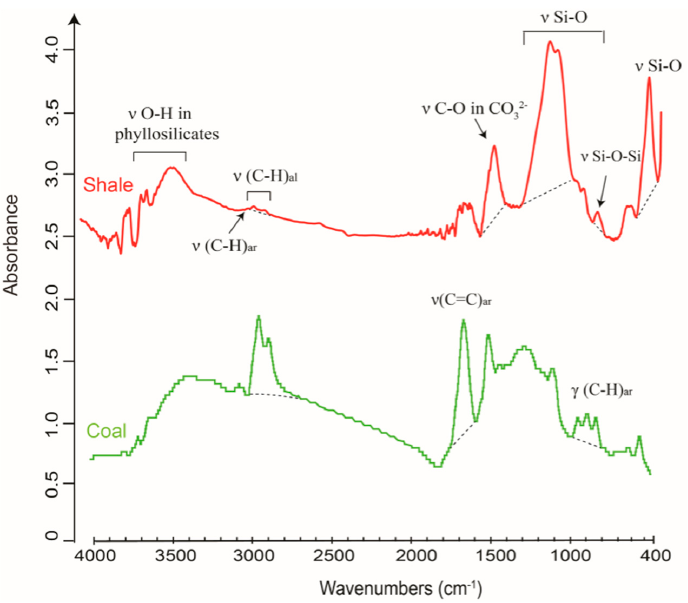
Figure 6. Comparison between the spectra of shale (red) and coal (green). Dashed lines are the linear baselines applied to the FTIR spectra. Note that the IR spectrum of shale contains strong absorbance of minerals occurring at 1500–400 cm − 1 , but low band intensity from organic matter at 3000–2800 cm − 1 .